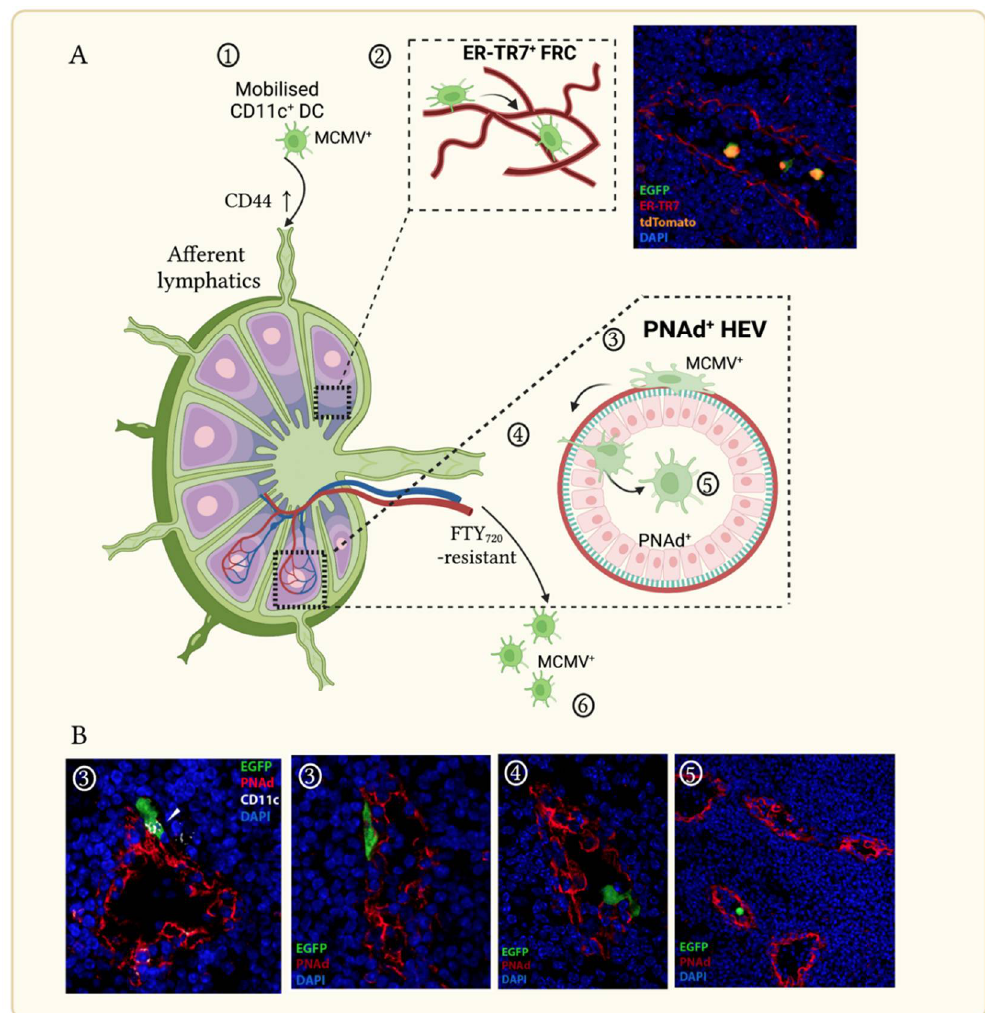
Figure 2. MCMV modulates dendritic cell (DC) directional decision-making in draining lymph nodes (LN). ( A ). Schematic showing MCMV-infected DC entry to LN draining the olfactory or lung mucosa via afferent lymphatics. (1) MCMV + DC traffic via afferent lymphatics, facilitated by CD44. (2) CD11c-cre mice infected with a MCMV mutant possessing a floxed EGFP upstream of a nuclear-localized td-Tomato exhibit color-switched CD11c + cells infiltrating the LN via ER-TR7 + fibroblastic reticular cells. (3) MCMV + CD11c + DCs of mice infected with EGFP-tagged MCMV associate with PNAd + high endothelial venules (HEV), then extravasate (4) to enter the HEV lumen via a mechanism resistant to fingolimod treatment (FTY 720 ). (5) Infected DC escape to the blood. (6) ( B ). Immunohistochemical analyses of LN draining the olfactory or lung mucosa taken days 1–3 p.i. showing MCMV + DC interaction with PNAd + HEV with reference to schematic pathway indicated numerically in ( A ). Arrow denotes punctate CD11c + expression by MCMV-infected DC.